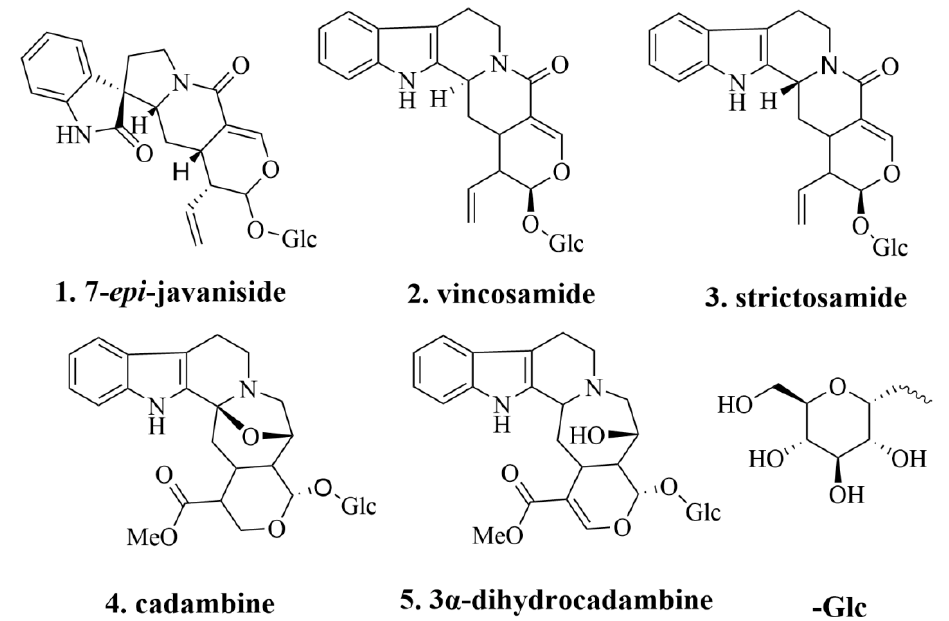
Figure 2. The structures of compounds 1 – 5 .